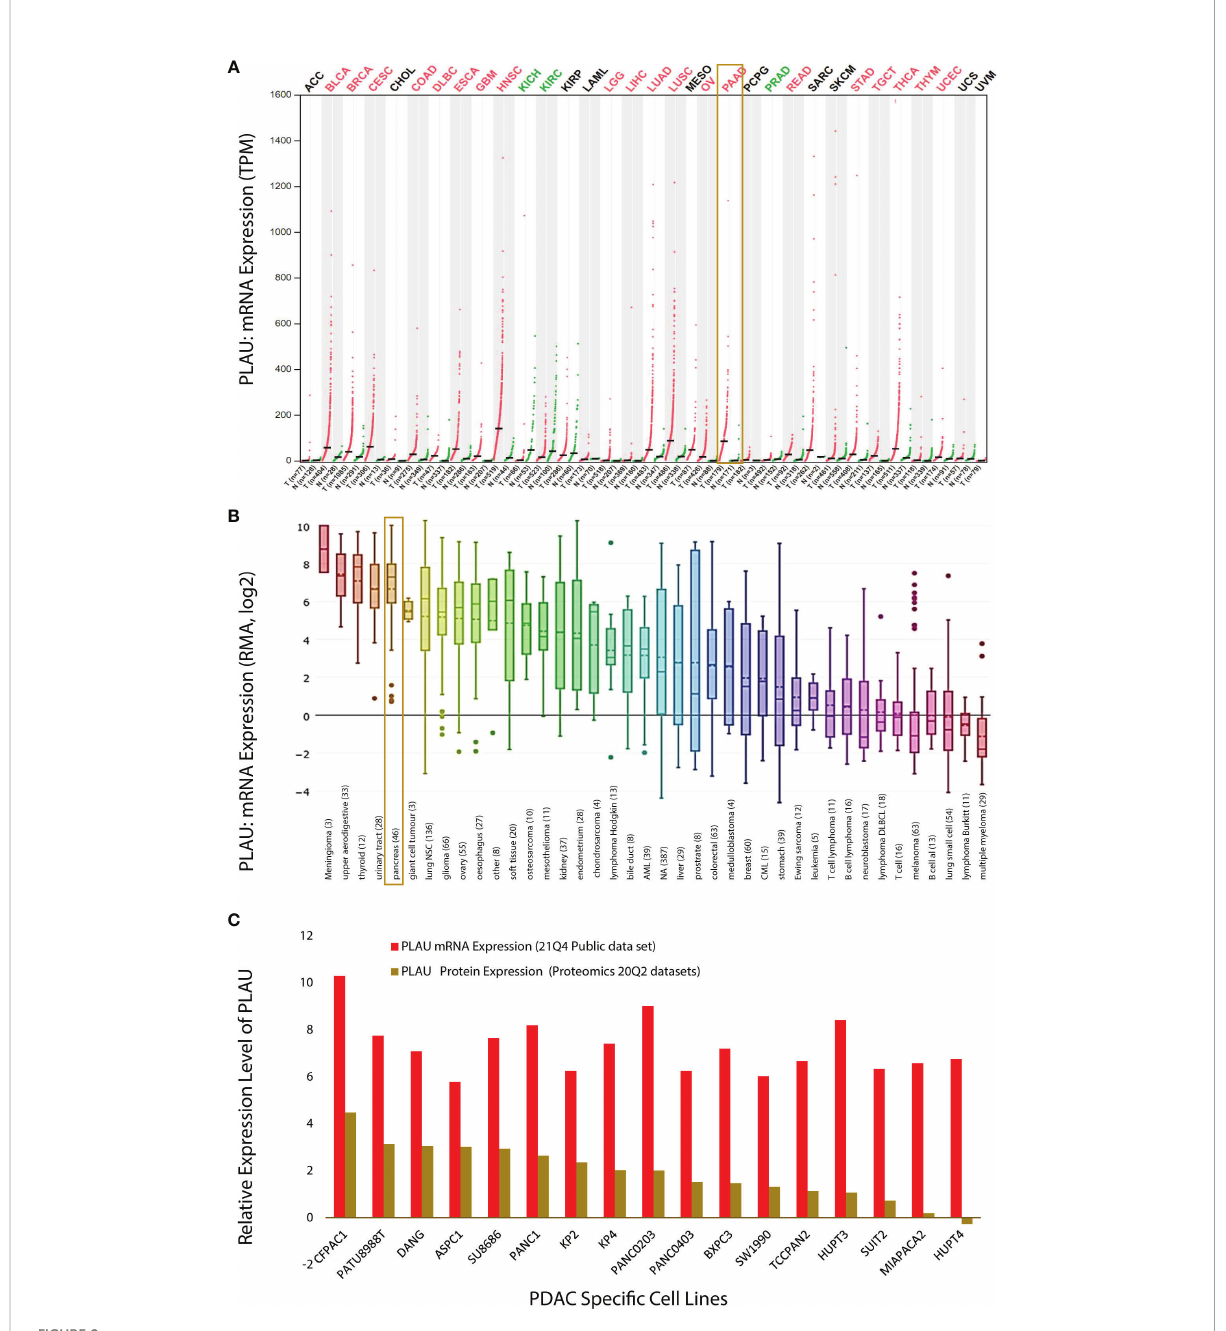
FIGURE 2 PLAU expression in cancers. (A) Dot plot depicting PLAU gene expression pro fi le across 33 cancer types and paired normal samples (TCGA normal plus GTEx), with each dot representing a distinct tumour or normal sample. The bar height represents the median expression of a certain tumour type or normal tissue. The comparison was performed using GEPIA (Gene Expression Pro fi ling Interactive Analysis). For each TCGA tumour (red), its matched normal and GTEx data (green) are given; T: tumour; N: normal; n: number. Y-axis: transcripts per million log2 (TPM + 1). X-axis: number of tumours and normal samples. (B) PLAU expression across 1111 human cancer cell lines from the Cancer Cell Line Encyclopedia (CCLE). Box plots showing RNA-seq mRNA expression data from CCLE, with the dashed lines within a box representing the mean. Cell lines derived from the same organ/organ system were grouped, and lineages are indicated at the bottom of the graph, with the number of cell lines per organ/organ system in parenthesis. The “ pancreas ” group includes the 44 pancreatic cancer cell lines listed in (ST2A). (C) Relative expression level of PLAU at mRNA and protein level in 17 PDAC cell lines using the depmap